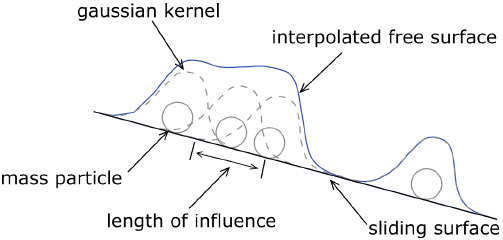
Figure 1. Schematic of the SPH technique to interpolate the free surface from the simulation mass particles. The length of influence is three smoothing